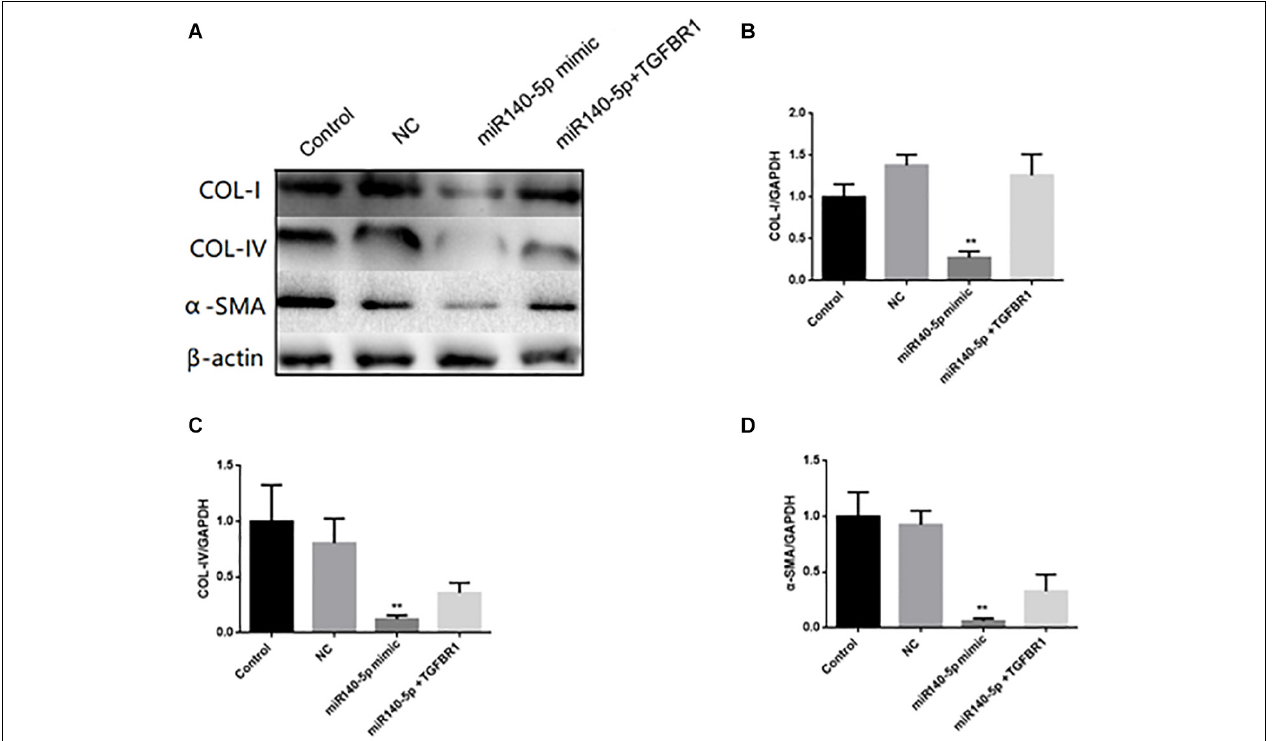
FIGURE 7 | TGFBR1 was involved in the effects of miR-140-5p on TGF- β 1-induced collagen accumulation and cell differentiation in HK2 cells. HK2 cells were transfected with miR-140-5p mimic and TGFBR1-expressing vectors, and then treated with TGF- β 1 (5 ng/ml) for 24 h. (A) The protein expression of COL-I, COL-IV and α -SMA was determined by Western blot. β -actin was detected as a loading control. ( B–D) The mRNA level of COL-I, COL-IV, and α -SMA was determined by qRT-PCR. Data was presented as mean ± SD of three experiments. Control: no transfection treatment, Negative control (NC): cells transfected with scrambled oligonucleotide. ∗∗ P < 0.01 versus